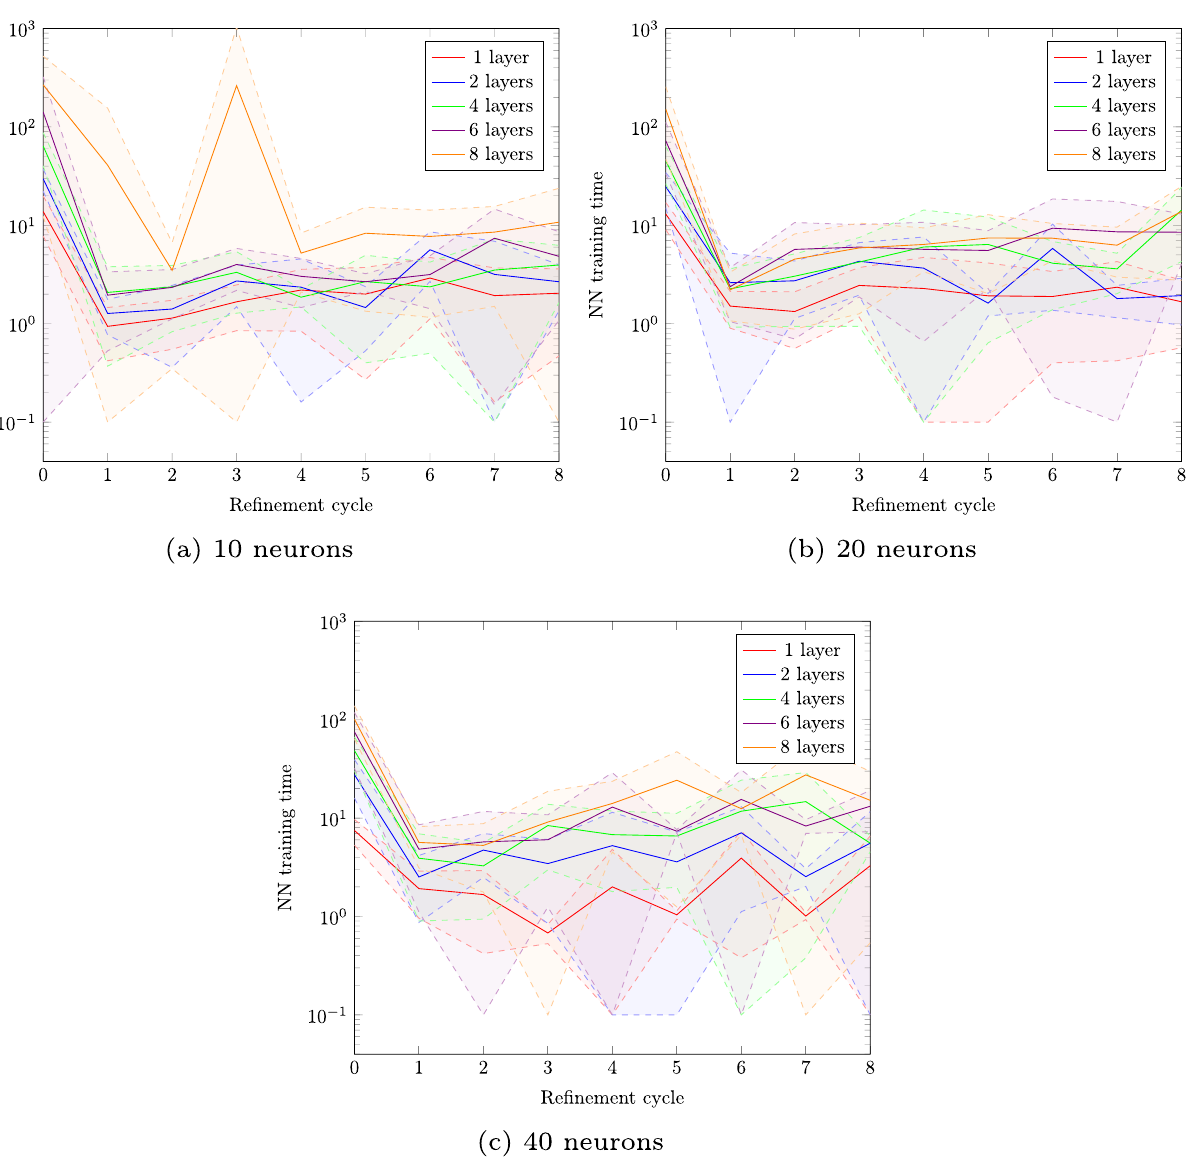
Fig. 4 Section 5.2: Neuronal network training times (in seconds) per refinement cycle for 10 independent runs for the Poisson problem with analytical primal and adjoint